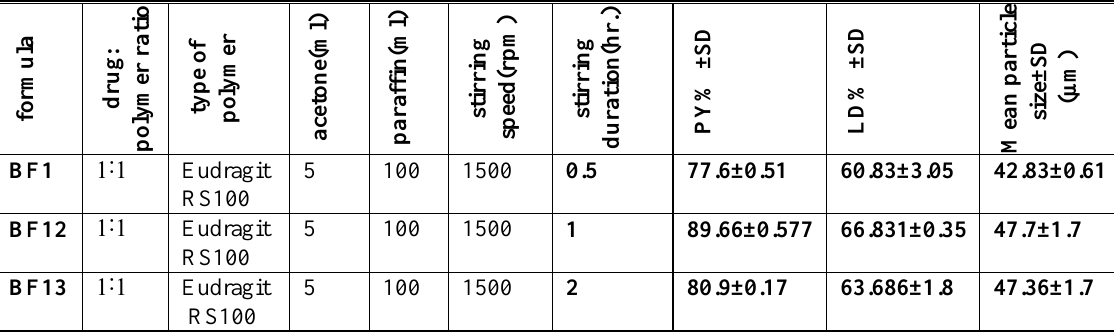
Table (4) Effect of stirring duration on physical prosperities of microsponges